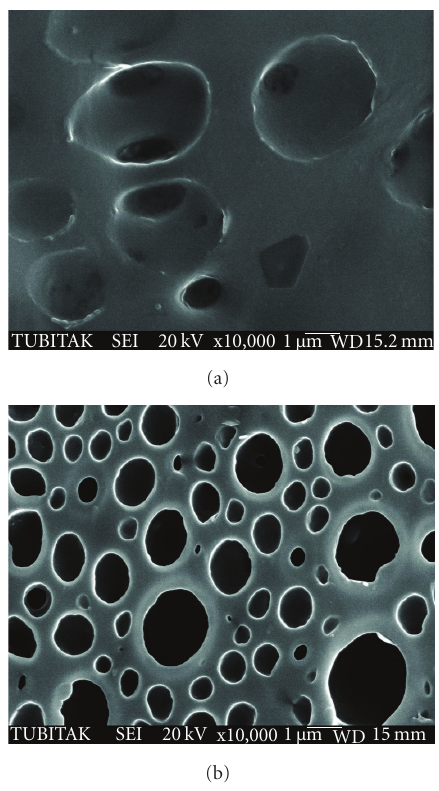
Figure 4: SEM analysis of Au-PP-PEG-2000 (a) and Au-PP-PEG- 4000 (b) on the 30th day of implantation (10,000x magnification). There are multiple depressed circular areas on surface of Au-PP- PEG-2000. These areas are transformed into “punched holes” in Au-PP-PEG-4000.